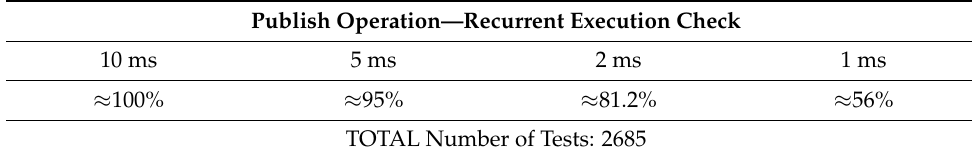
Table 5. OPC UA Update Node—Virtualized Linux OS—Publish Operation.